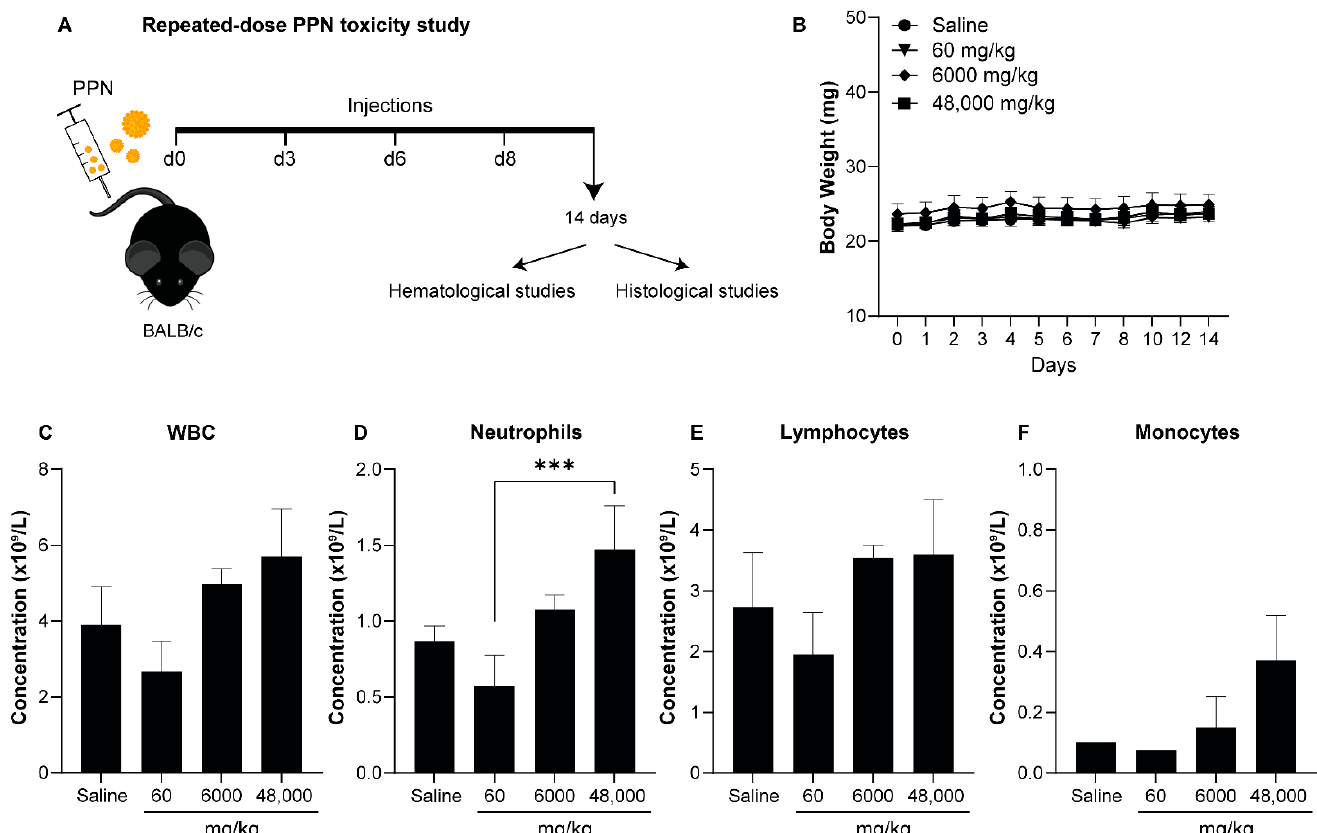
Figure 7. ( A ) Schematic depicting the experimental procedure to evaluate the toxicity of PPNs in BALB/c mice upon repeated doses. ( B ) No reduction in body weight was observed after IV administration of repeated doses of PPNs for the entire duration of the study (14 days). A slight elevation of ( C ) WBC, ( D ) neutrophils, ( E ) lymphocytes, and ( F ) monocytes was observed at the higher doses (6000 mg PPN/kg and 48,000 mg PPN/kg) when compared to the saline control group. The data represent the mean ± SEM of five mice and the statistical significance was determined using Tukey’s multiple comparison test (*** p < 0.001).